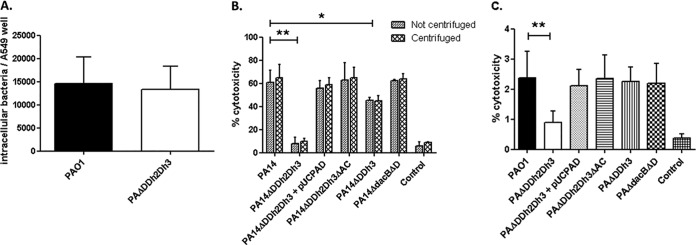
A549 cell invasion and cytotoxicity assays of strains PAO1 and PA14 and mutants derived from the two strains. (A) PAO1 invasion assay. The number of invasive CFU per well of A549 cells (multiplicity of infection [MOI] of 100) after 3 h of infection is shown. Values are means plus SD for at least three wells from three independent plates. (B and C) Cytotoxicity results after 3 h of infection (MOI of 100) of strains PA14 (B) and PAO1 (C). Values are means plus SD for at least three wells from three independent plates. The values that are significantly different by Student’s t test are indicated by bars and asterisks as follows: *, P < 0.05; **, P < 0.0001. The rest of the single and double ampD mutants of both PAO1 and PA14 showed wild-type levels of invasiveness and/or cytotoxicity (not shown).